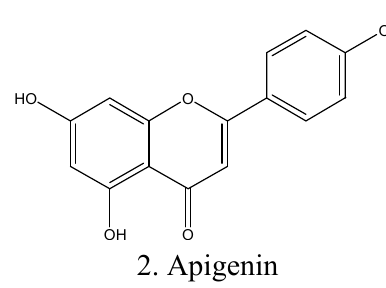
Figure 1. Structure of galangin ( 1 ) and apigenin ( 2 ).